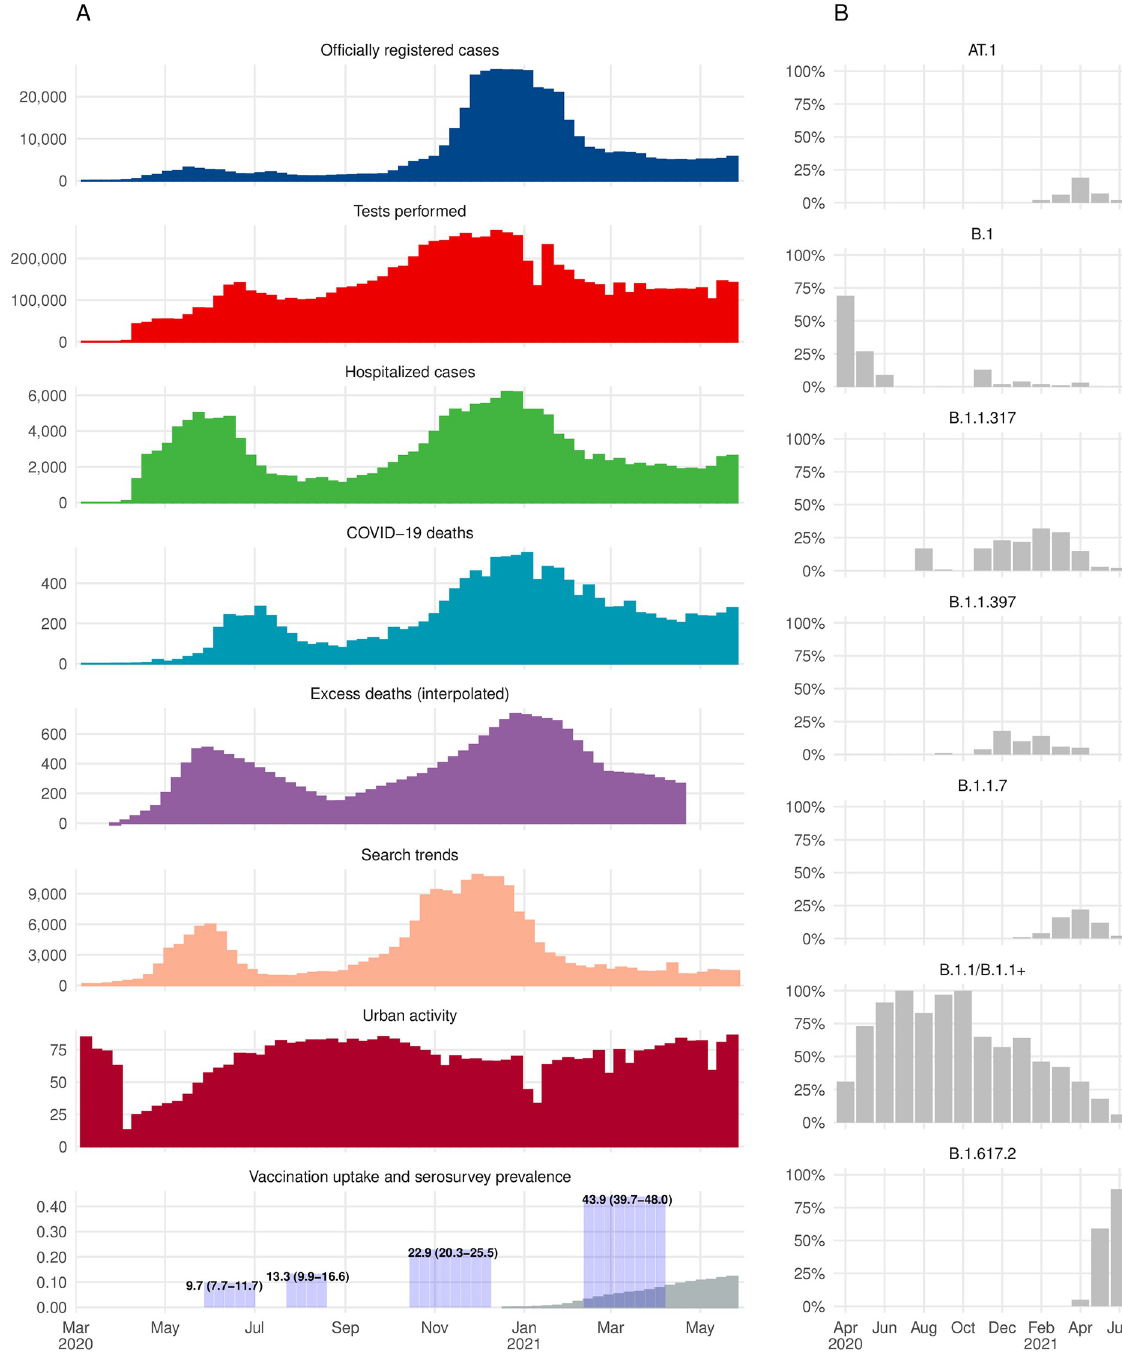
Fig 3. Combining available surveillance data to monitor the pandemic course in St. Petersburg during March-May 2020–2021. (A) Weekly data of officially registered cases, tests performed, hospitalised cases, COVID-19 deaths, interpolated excess deaths (from monthly data), search trends, urban activity, and vaccination uptake combined with seroprevalence estimates; (B) Monthly data on SARS-CoV-2 variants monitoring during April-June 2020–2021.